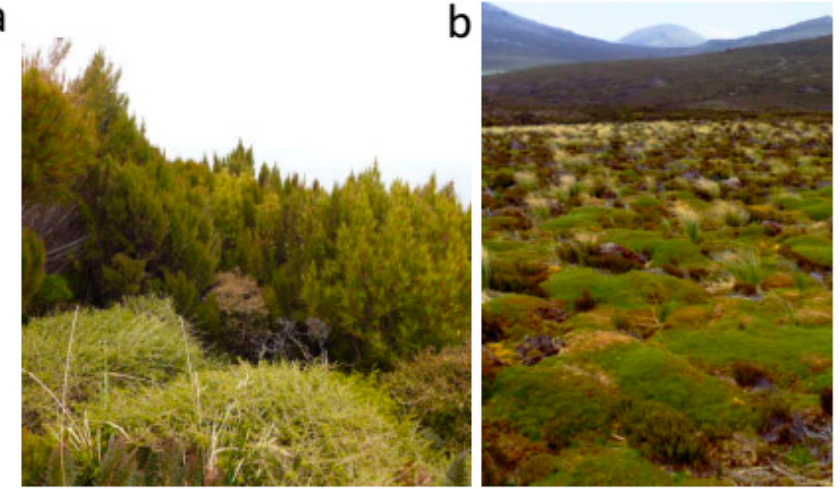
Figure 2. Cont . Figure 2.